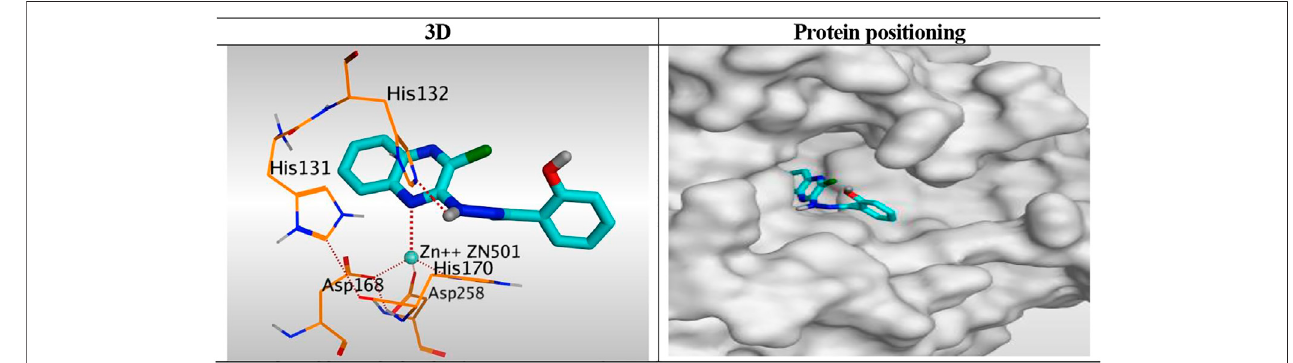
FIGURE 8 | 3D representation and positioning for the docked 6 k inside the tubular pocket of the HDAC receptor.